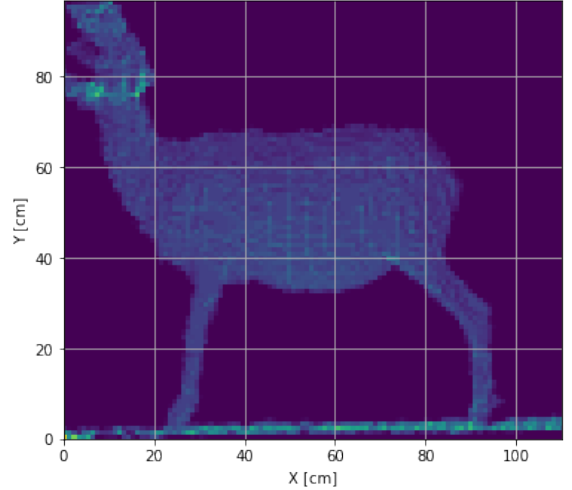
Figure 6. Segmented depth histogram on the